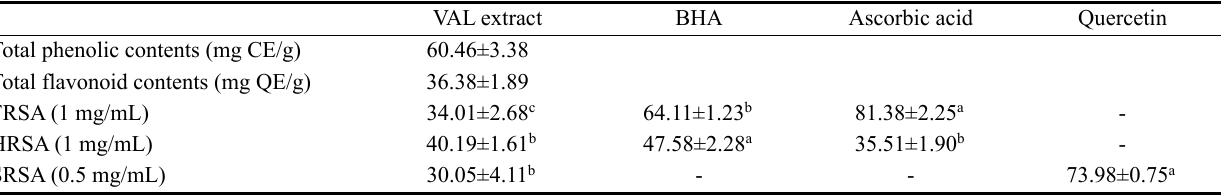
Table 1. Total phenolic and flavonoid contents along with antioxidant activities of the mistletoe ( Viscum album L.; VAL) ethanol